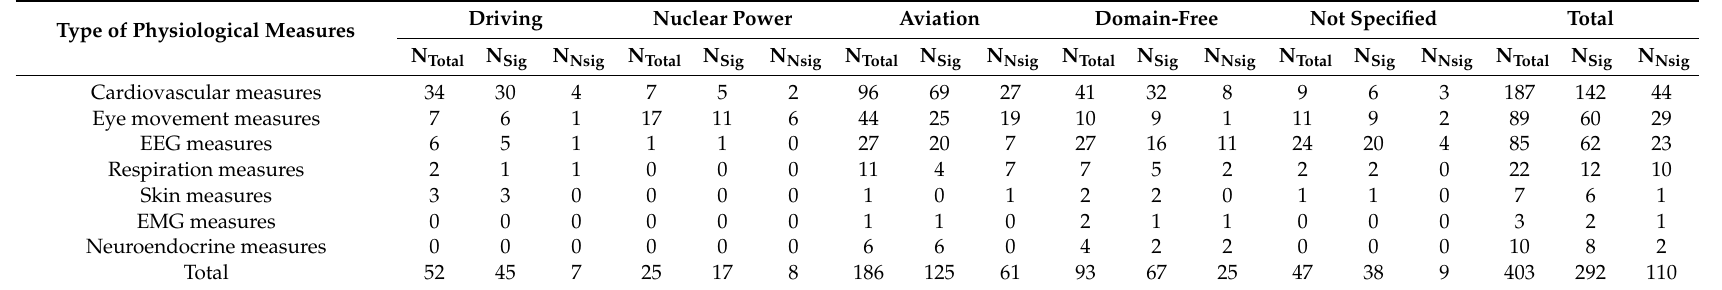
Table 3. Physiological measures and their statistical significance reported in the reviewed studies.